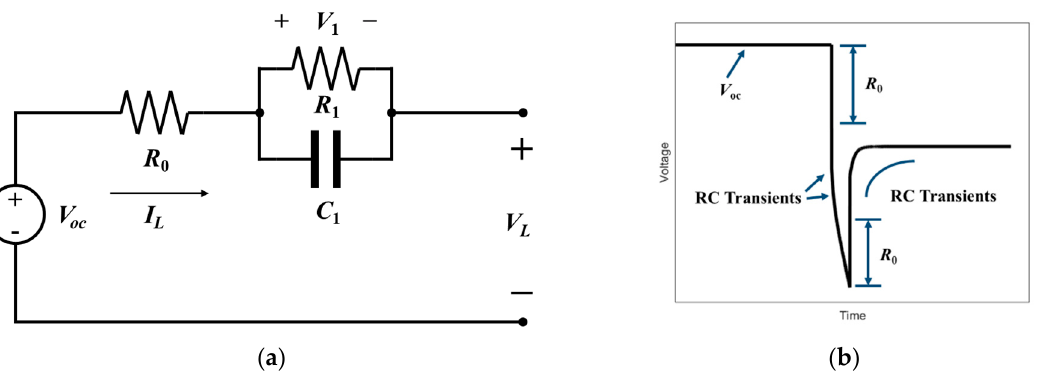
Figure 1. Battery parameter identification: ( a ) equivalent circuit battery model and ( b ) parameter extraction from discharge section.